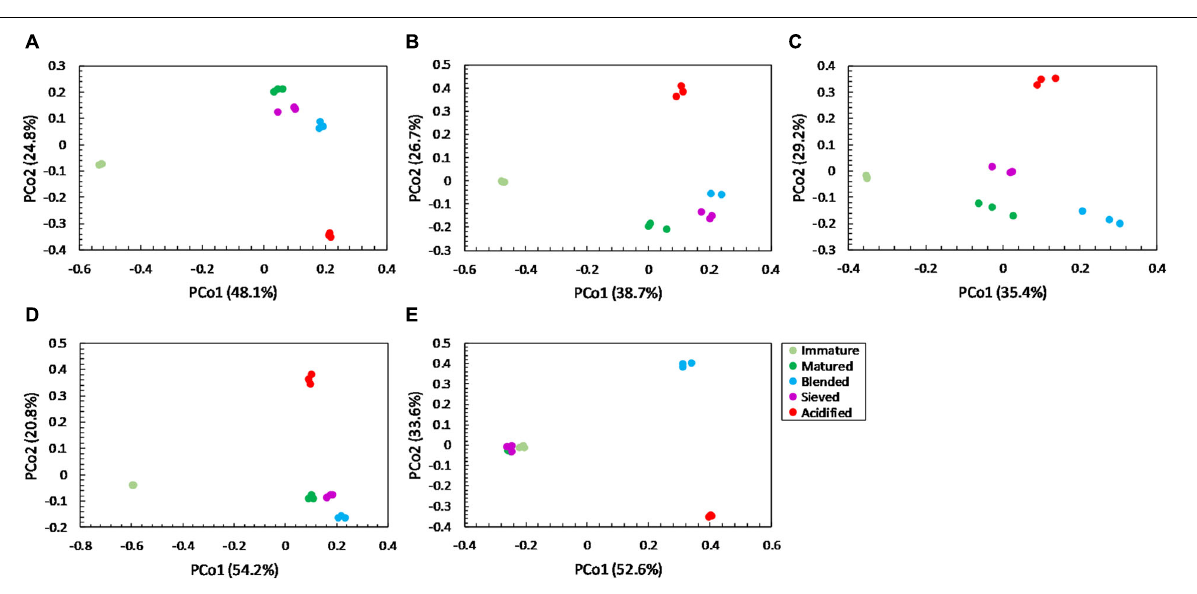
FIGURE 5 | Major shifts in bacterial community distribution between immature, matured, blended, sieved and acidified composts in the five compost batches. – Principal Coordinate Analysis (PCoA) profile of pairwise community dissimilarity (Bray-Curtis) indices of bacterial (16S V3-V4 rRNA gene) sequencing data of